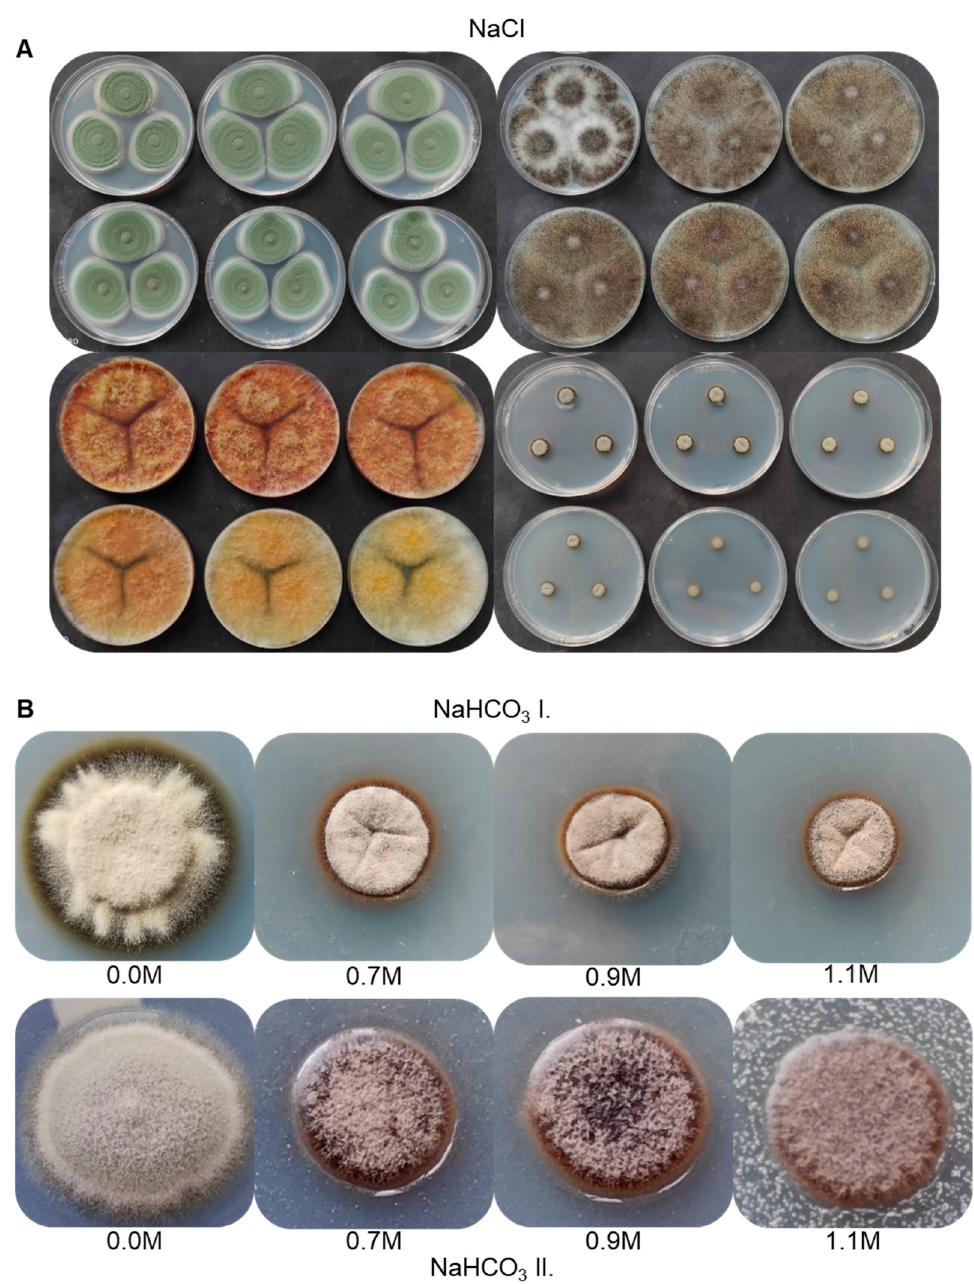
Figure 4. Colony forming ability of the examined fungal strains on NaCl- and on NaHCO 3 -containing PDA plates. ( A ) Tolerance to NaCl. Green mold: Penicillium expansum SZMC 2175; blackish mold: Aspergillus niger CBS 554.65; orange-yellowish mold: Fusarium graminearum FGSC 9075; small grey colonies: Cyphellophora olivacea AGSC12. The NaCl concentrations are the following in the top line from left to right: 0.0 M (control), 0.1 M, 0.3 M and in the bottom line from left to right: 0.5 M, 0.7 M, 0.9 M. All the tested strains were able to produce colonies at the different concentrations. Photos were taken after 7 days of cultivation. ( B ) The strain C. olivacea AGSC12 tolerance to NaHCO 3 I and II contained PDA plates (see methods). This strain showed a striking tolerance to NaHCO 3 . Photos were taken after 10 days of cultivation. The diameters of the colonies are not to scale; these photos concentrate on the colony morphologies.